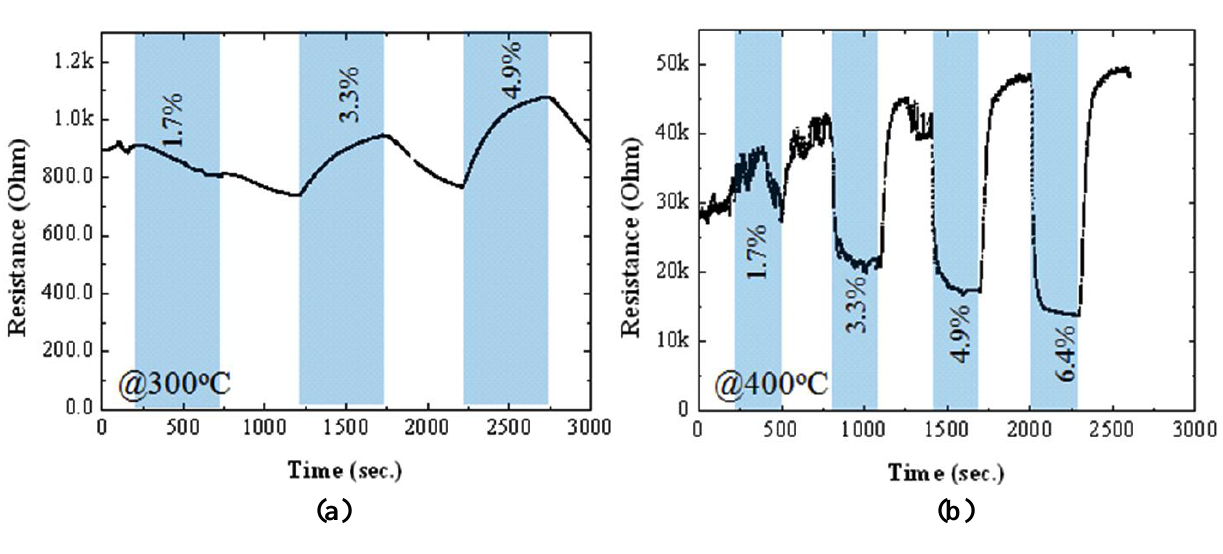
and LPG (1.7~6.4 vol.%) at operating temperatures of 2